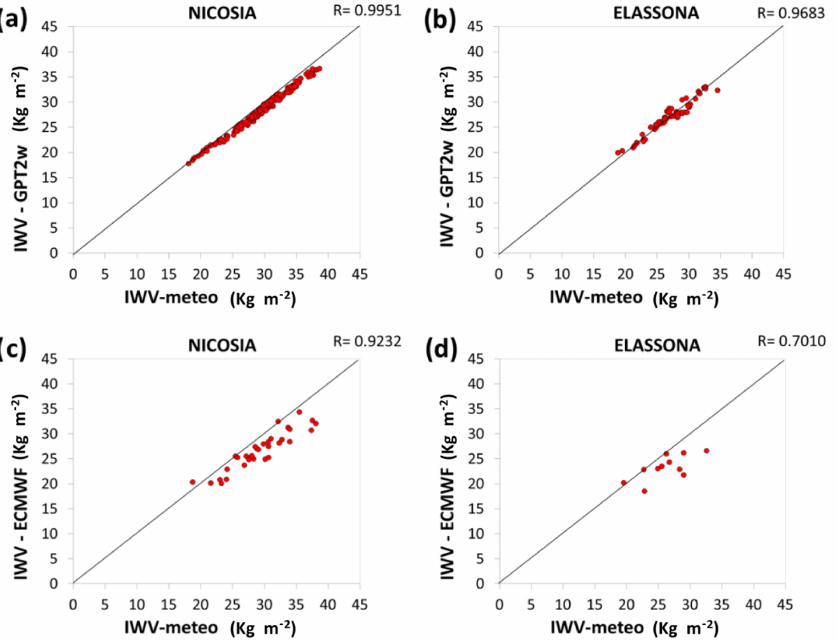
Figure 5. Scatter plots of IWV computed from GNSS receivers by using surface T , P from collocated meteorological stations with IWV computed from GNSS receivers by using (1) GPT2w model (upper panels) and (2) ECMWF model (lower panels) for Nicosia (a, c) and Elassona (b, d) sites. Black diagonal lines represent R = 1. The number of points (red dots) used for the analysis are N = 12 and N = 32 for Elassona and Nicosia sites, respectively.